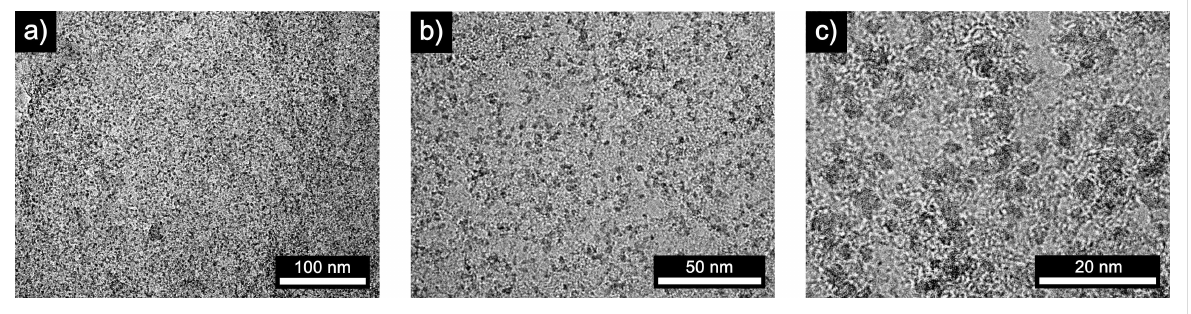
Figure 4: TEM micrographs of graphene functionalized with crystalline iron oxide nanoparticles using an increased ratio of copper to iron oxide etchant. Magnification increases from a) to c). Graphene on copper foil was etched with a solution of 1 M iron(III) chloride in 10% hydrochloric acid.